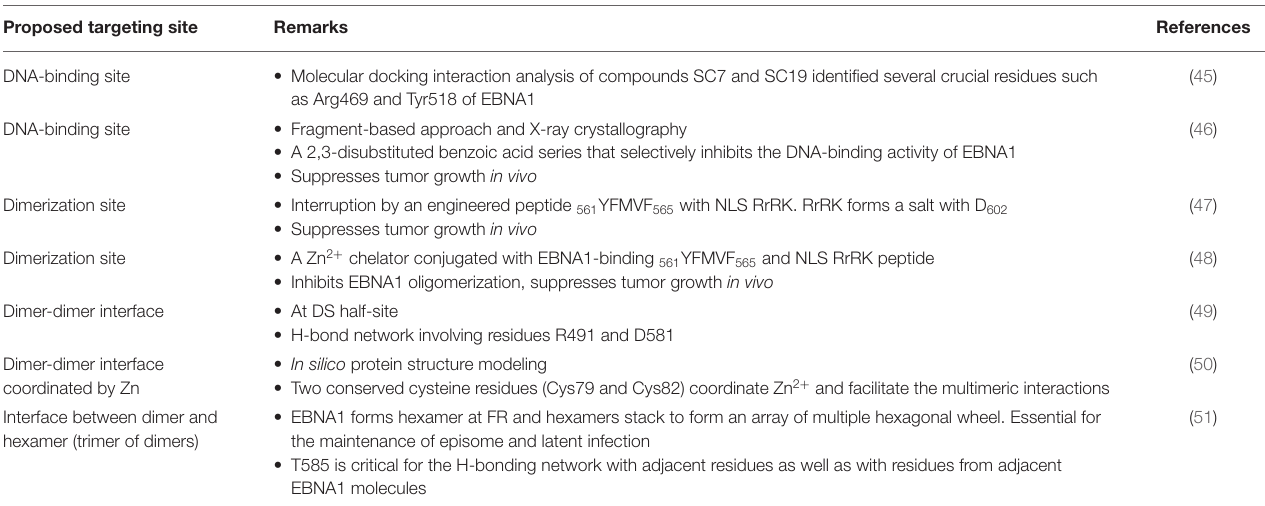
TABLE 1 | Therapeutic targeting of EBNA1 dimerization or